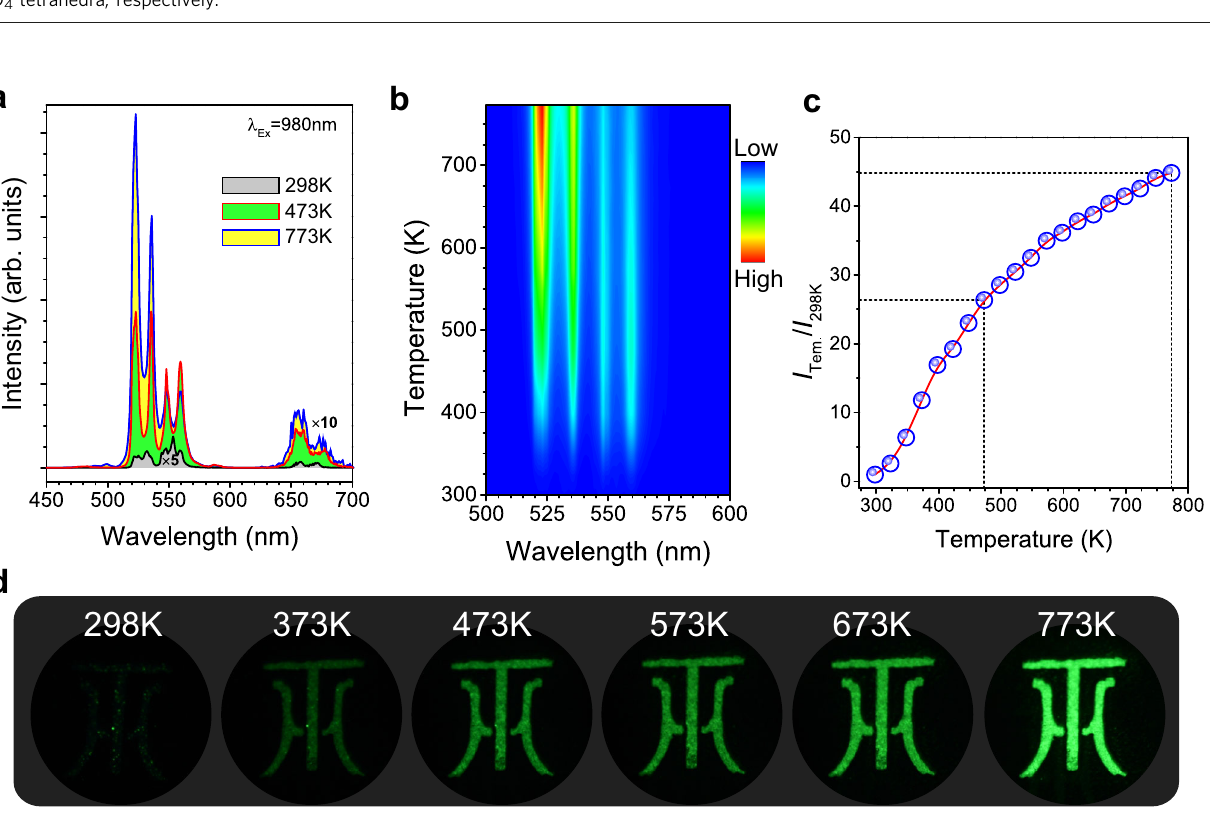
Fig. 3 Thermally enhanced upconversion emission. a UC spectra of Sc 2 (MoO 4 ) 3 :20%Yb/1%Er phosphor with different temperatures. b Two-dimensional UC emission topographical mapping within the temperature from 298 to 773 K. c Normalized UC emission intensity as a function of temperature. d UC photographs of Sc 2 (MoO 4 ) 3 :20%Yb/1%Er phosphors at various temperatures recorded by the Nikon D750 camera upon 980 nm